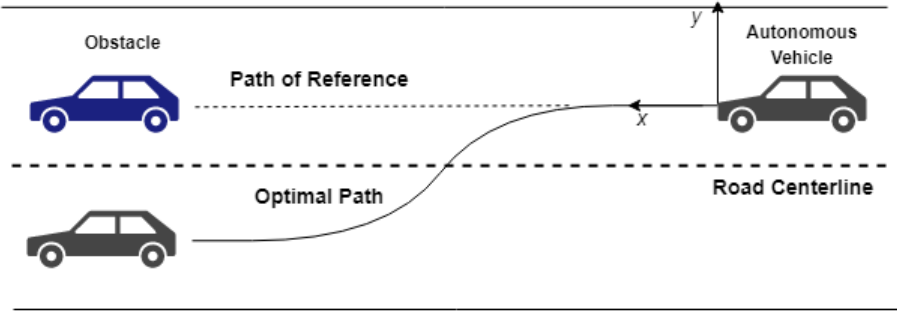
Figure 5. Overtaking a moving